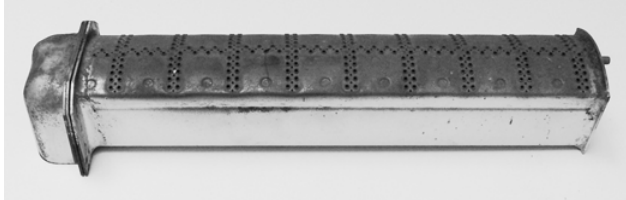
Figure 16. Burner from domestic central heating boiler.